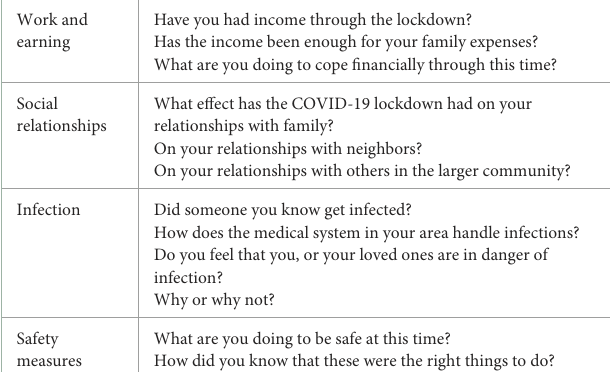
TABLE 2 Areas in which open-ended questions were asked, with some of the